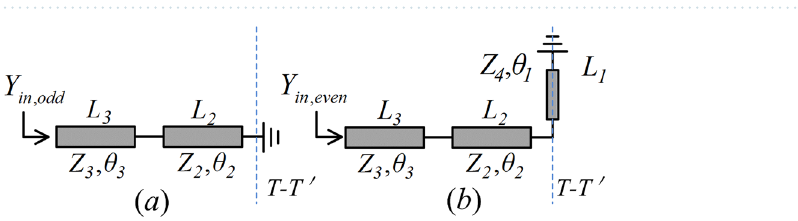
Figure 3. ( a ) The geometry of SSLSIR without slit line. ( b ) The equivalent circuit of SSLSIR without slit line. ( c ) The geometry of SSLSIR with two slit line loaded. ( d ) The equivalent circuit of SSLSIR with two slit line loaded.